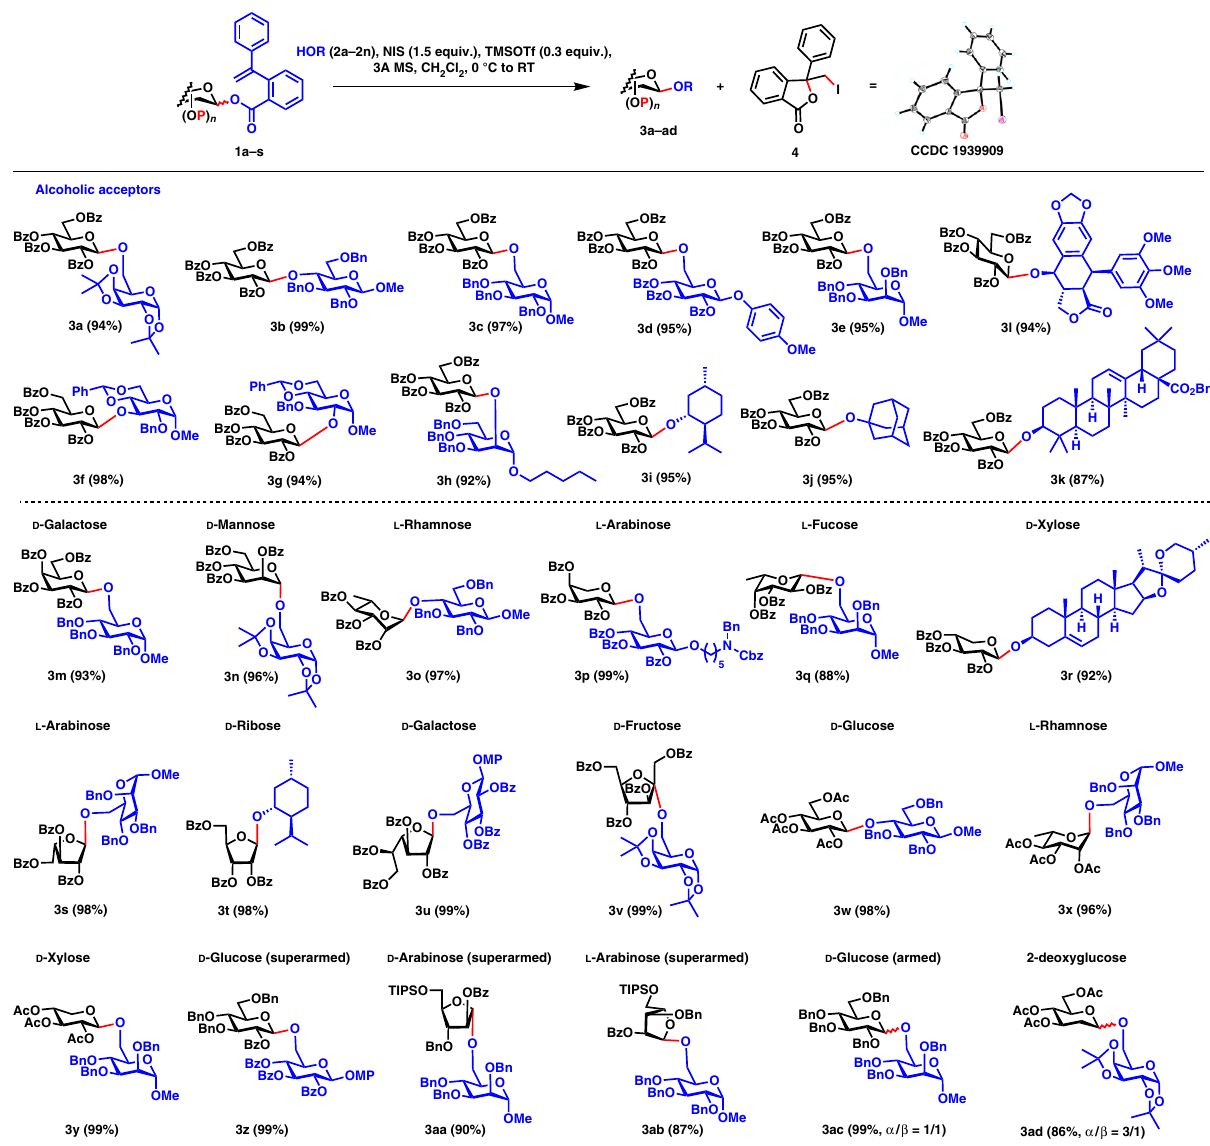
Fig. 2 Scope of synthesis of O -glycosides with glycosyl PVB donors. Highlighted in blue are leaving groups and nucleophilic acceptors and in red are chemical bonds cleaved and formed. Ac acetyl, TIPS triisopropylsilyl, MP 4-methoxyphenyl, Cbz benzyloxycarbonyl, MS molecular sieves, RT room